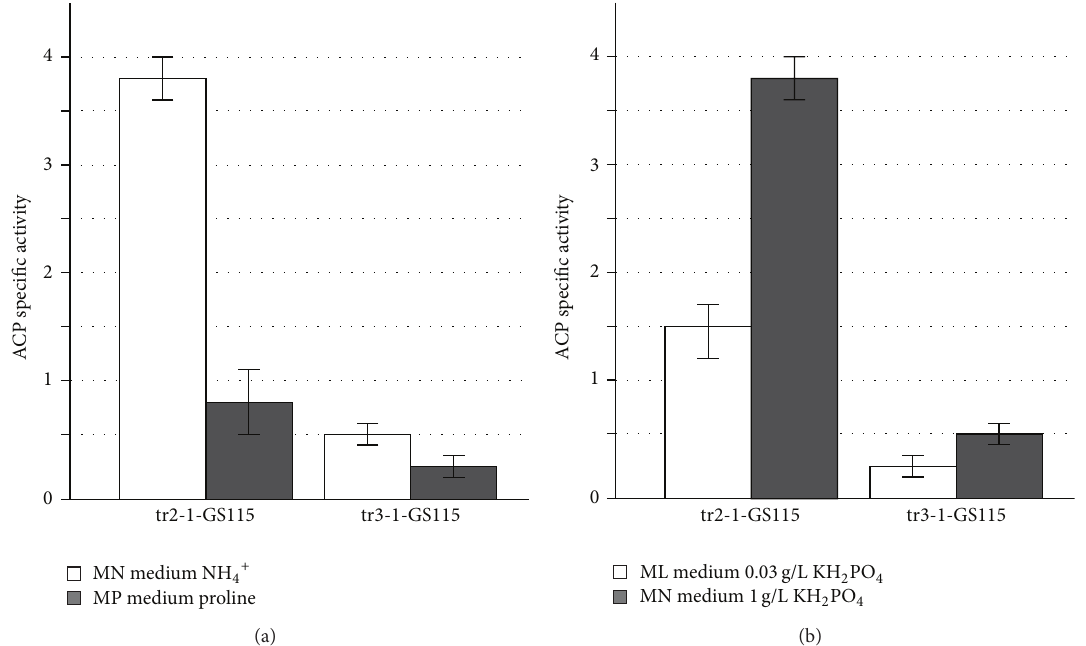
Figure 3: ACP specific activity of P. pastoris strains tr2-1-GS115 ( phox PAOX1-PHO5 HIS4 ) and tr3-1-GS115 ( phox PAOX2-PHO5 HIS4 ) grown in different media: (a) cells were grown in media with different nitrogen sources (MN with ammonium sulphate and MP with proline); (b) cells were grown in media with different concentrations of KH 2 PO 4 (MN with 1g/L and in ML with 0,03